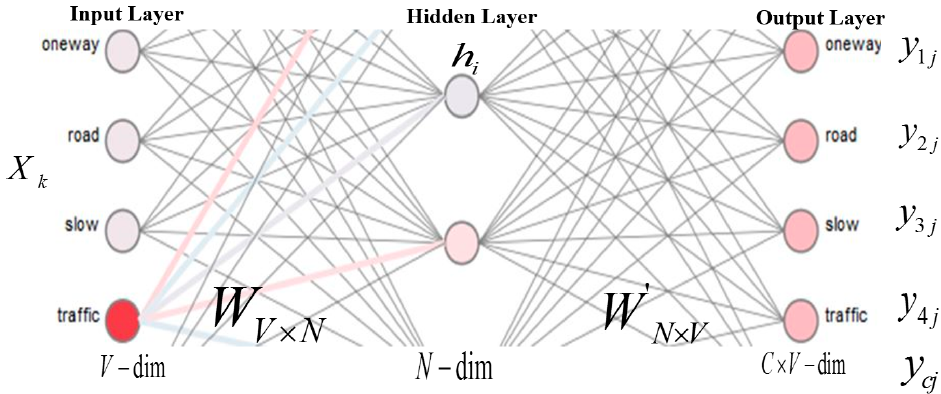
Figure 3. Trained skip-gram model for transport data.